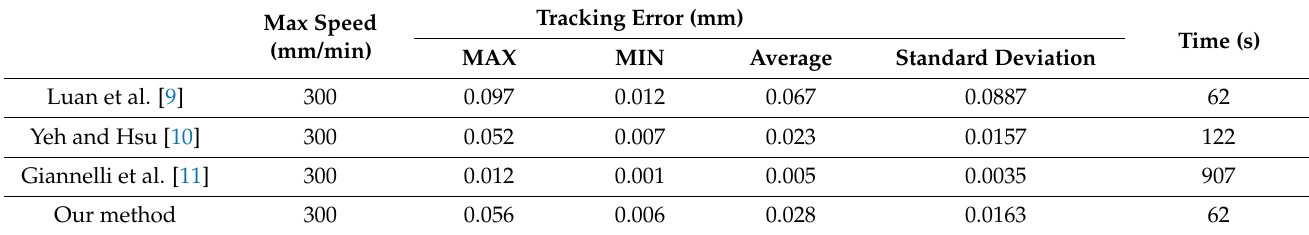
Figure 17. Cutting ∞ shape using our method: ( a ) feed rate, ( b ) acceleration, and ( c ) jerk. Table 7. Tracking error and processing time of ∞ shape. Table 7. Tracking error and processing time of ∞ shape.